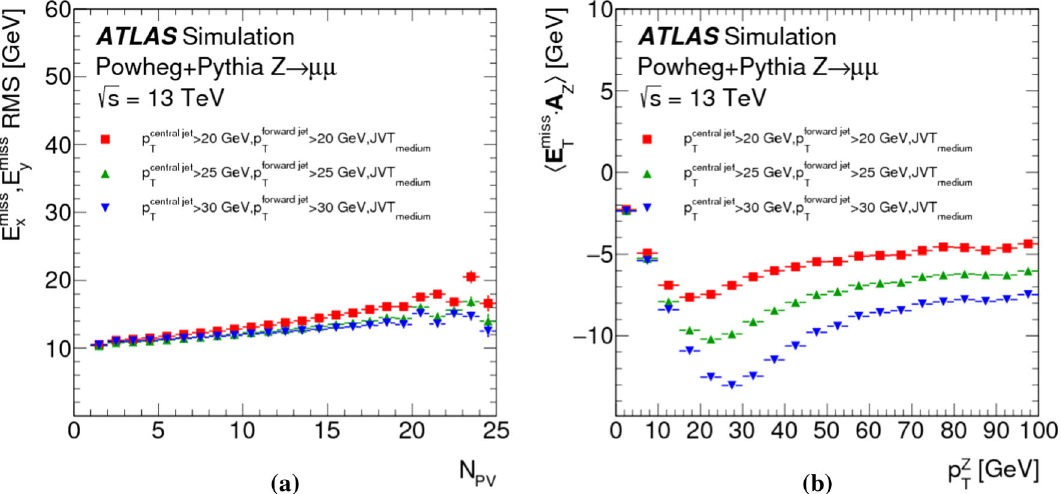
Fig. 18 E miss resolution and scale for different global jet- p T thresh- of the Z boson. The same respec- of the transverse momentum p Z T T tive thresholds are applied to the transverse momentum of jets within olds, for Z → μμ events in MC simulation. The a E miss resolution is T | η | < 2 . 4 ( p central jet shown as function of the pile-up activity measured by the number of ) and for forward jets with | η | ≥ 2 . 4 ( p forward jet T primary vertices N PV , and the b E miss response is shown as function , p forward jet > { 20 , 25 , 30 } with p central jet T T T